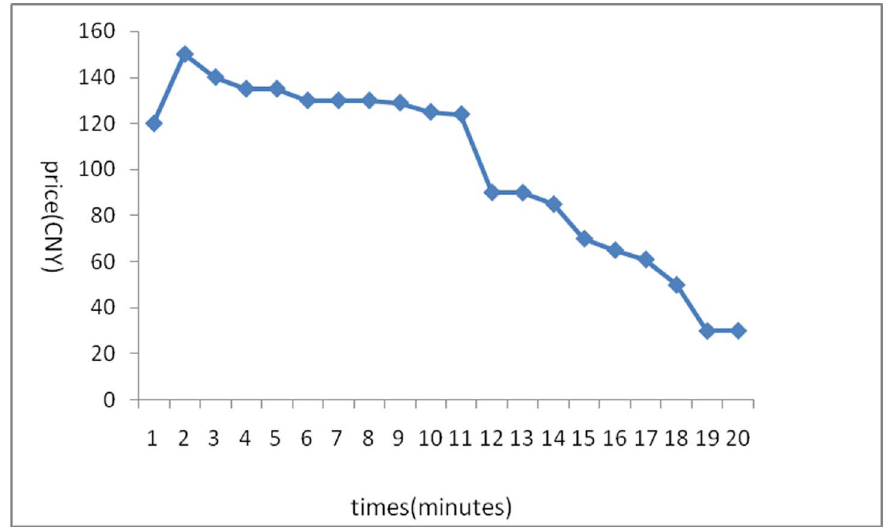
Figure 5. Second Experiment of a Unilaterally Price-Falling Situation with Manipulation.